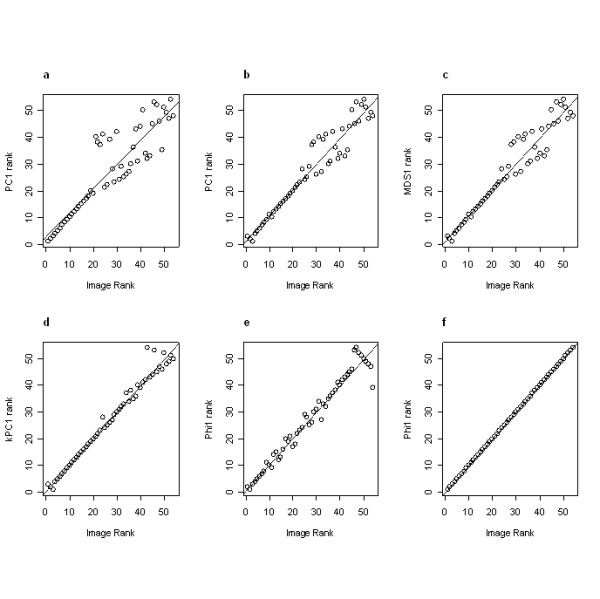
Scatter plots of image ordering for six projection methods. (a) Regression of ranked eigenfunction values calculated by PCA-correlation vs. actual ordering. (b) Regression of ranked eigenfunction values calculated by PCA-covariance vs. actual ordering. Note that the scores have been reverse sorted for consistency with the other plots. (c) Regression of ranked eigenfunction values calculated by nonmetric MDS vs. actual ordering. (d) Regression of ranked eigenfunction values calculated by kernel PCA (ε = 1,040) vs. actual ordering. (e) Regression of ranked eigenfunction values calculated by the spectral method from Ng et al. (ε = 70) vs. actual ordering. (f) Regression of ranked eigenfunction values calculated by the spectral method from Lafon [3,4] vs. actual ordering.